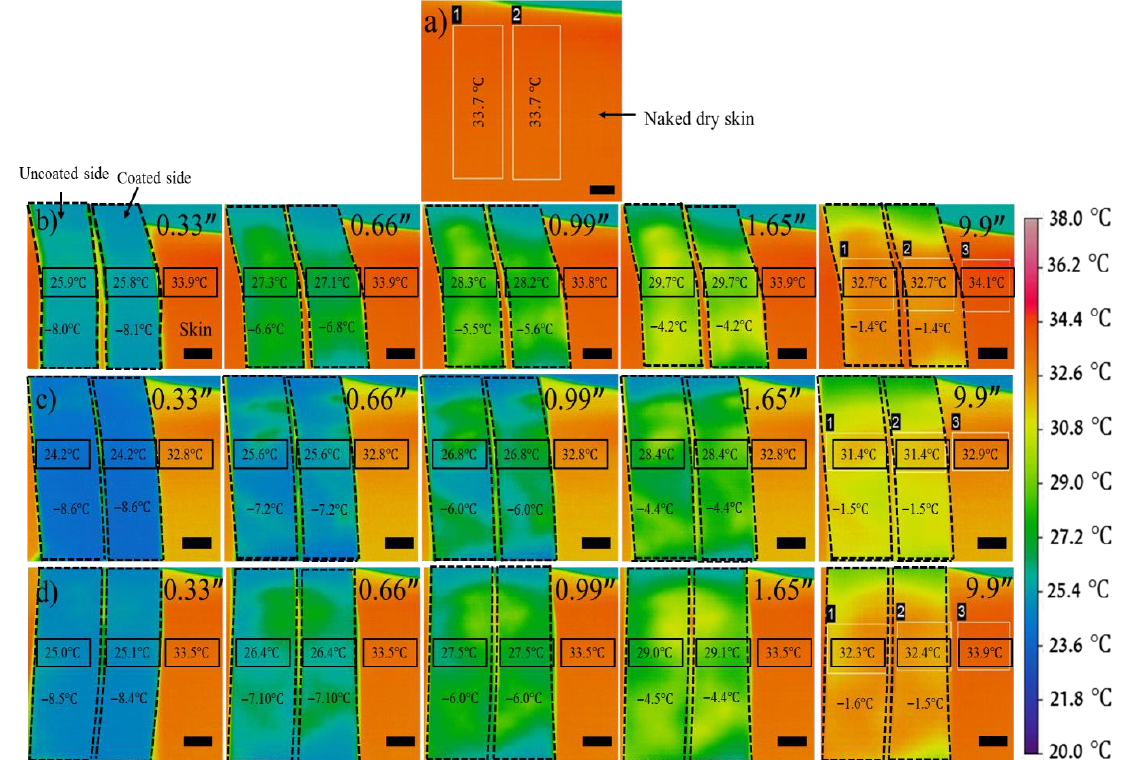
Figure 4. IR thermography images of ( a ) naked dry skin; naked dry skin partially covered with: ( b ) Directional water transport polyester fabric; ( c ) Control fabric; and ( d ) NaOH pre-treated fabric. The top right number indicates the time of the frame. The middle line numbers are the surface temperature on fabrics and skin. The bottom line numbers are the temperature difference between the fabrics and skin. The fabric covered areas (dashed line framed), and the other areas are naked skin (Scale bar 1 cm).